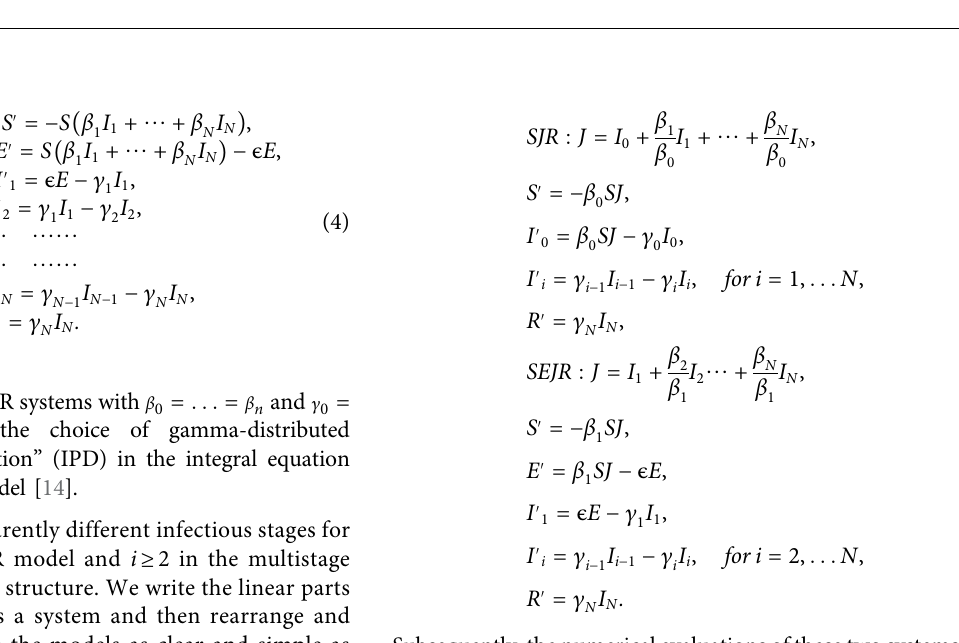
FIGURE5| Numerical solutions of the multistage SIR model for different stage numbers N (cid:2) 5 , 10 , 30, and 60. Here, R 0 (cid:2) 2 . 5and c (cid:2) 0 . 2 × N . In the graphs, *represents the location of the maximum value of J and o represents the location of the in fl ection point of R . Graphs show that there is a time shift between these